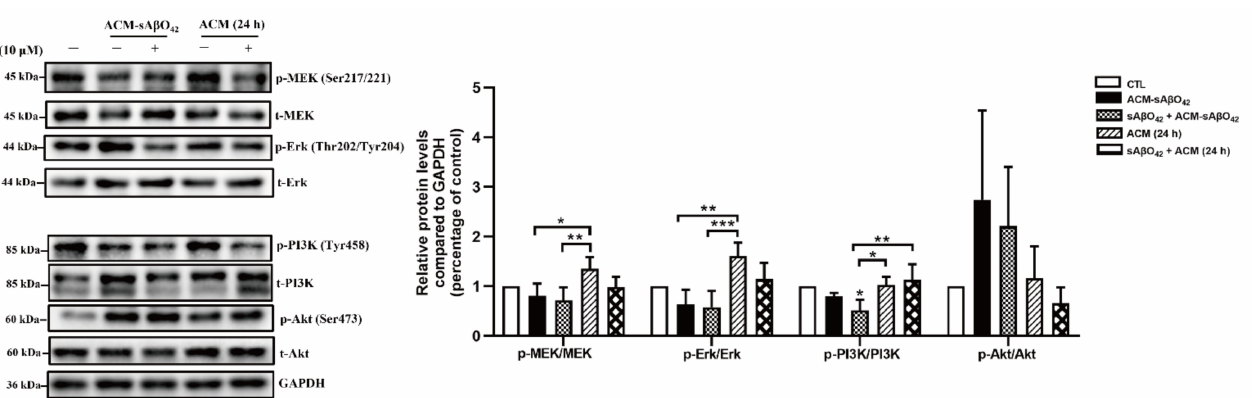
Figure 11. Resting ACM and ACM-sA β O42 had opposite effects on endothelial properties and protein expression of junctional proteins. ( A ) TEER value of the bEnd.3 monolayer after the treatment of ACM sA β O42 (10 µ M for 24 h), resting ACM (24 h), or exogenous sA β O42 alone or in combination. ( B ) The protein expression levels of tight junction proteins ZO-1 and claudin-5. Data are shown as means ± SD of at least three independent experiments and were analyzed by one-way ANOVA followed by a post hoc Dunnett’s test and a post hoc Tukey’s test. * p ≤ 0.1, ** p ≤ 0.01, *** p ≤ 0.001, **** p ≤ 0.0001 vs. control group or between two compared groups.